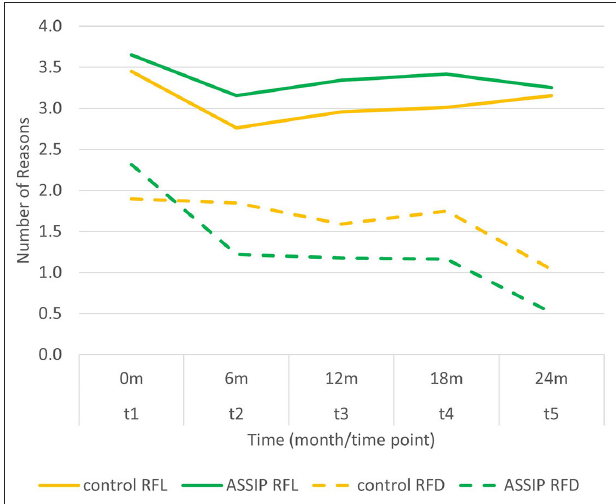
FIGURE 1 | Mean number of reasons for living (RFL) and reasons for dying (RFD) over the course of the two-year follow-up.